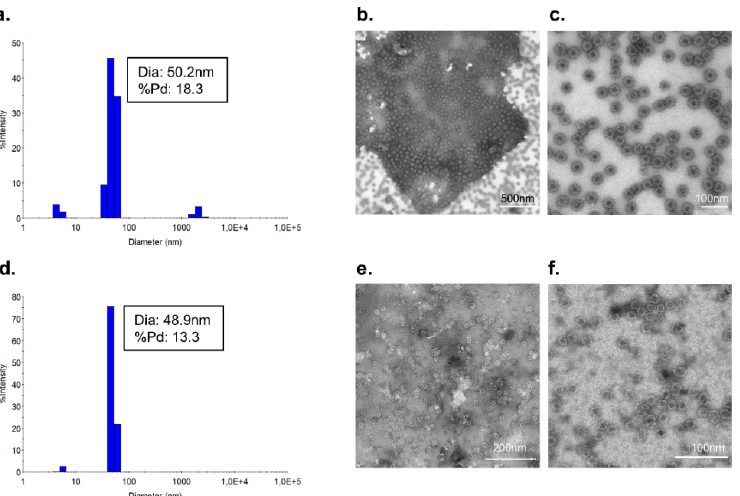
Figure 3. Vaccine quality assessment. Dynamic light scattering (DLS) analysis shows the % intensity of purified cVLP:IL ‐ 1 β vaccines. The average diameter and polydispersity (% Pd) are annotated for each peak. Transmission electron microscopy (TEM) images of negatively stained purified cVLP:IL ‐ 1 β vaccines. ( a ) DLS analysis of purified cVLP:IL ‐ 1 β ( b , c ) TEM image of cVLP:IL ‐ 1 β vaccine. ( d ) DLS analysis of purified cVLP:IL ‐ 1 β Q15G. ( e , f ) TEM image of cVLP:IL ‐ 1 β Q15G vaccine.